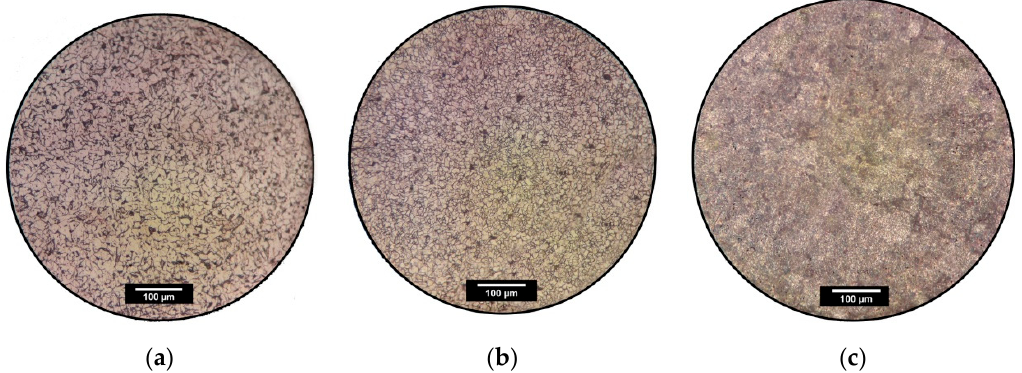
Figure 31. Microstructures of selected steels to experimental tests (250× magnification): ( a ) S235JR + N; ( b ) S355MC; and ( c ) 41Cr4.